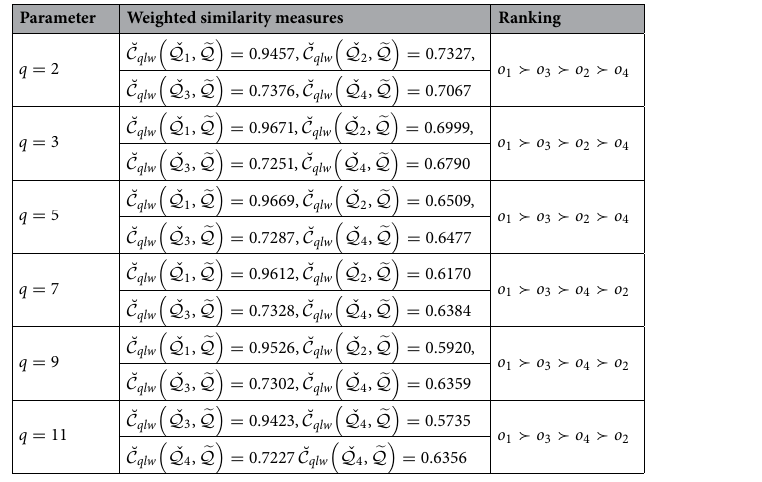
Table 9. Ranking of alternatives under different values of q.